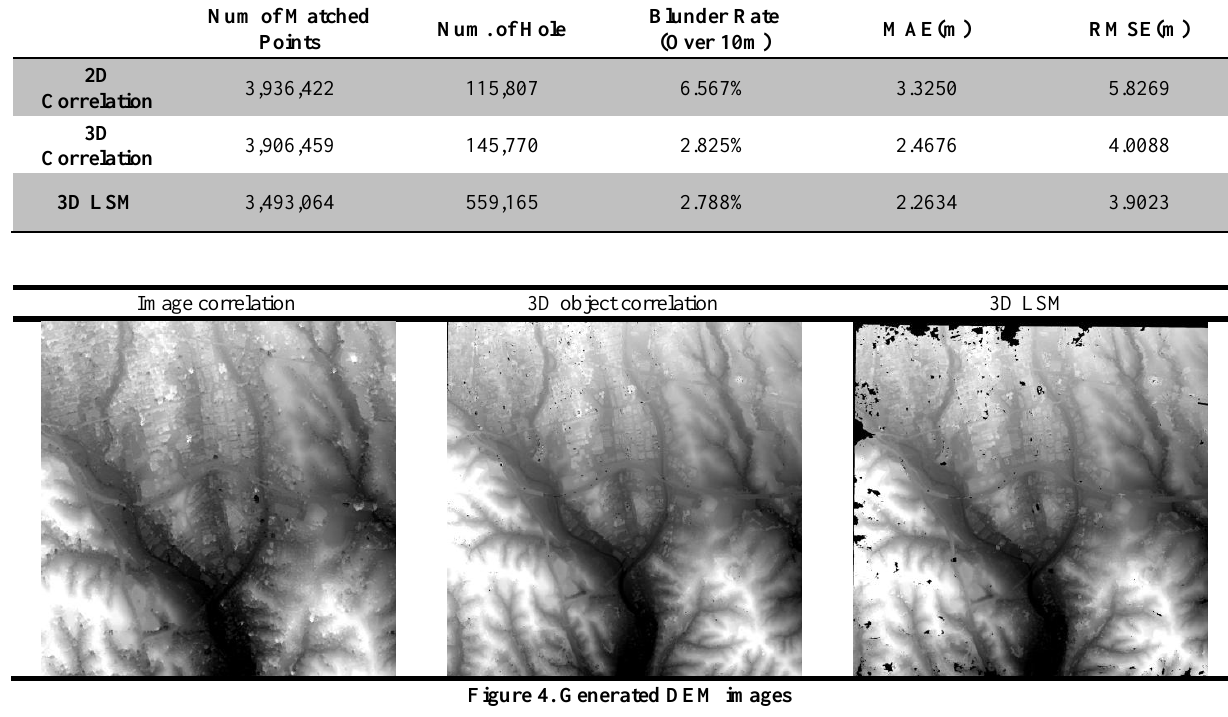
Table 4. DEM accuracy test results (Total 4,052,229 Points)